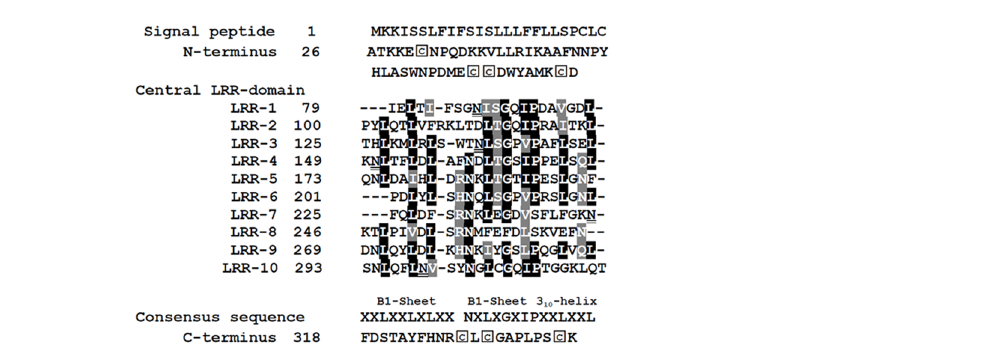
Fig 1. The PGIP-specific consensus sequence xxLxLxx.NxLx..GxIPxxLxxL.xxL in leucine-rich repeat units of CkPGIP1. Secondary structure elements (sheets B1, B2, and 3 10 -helix) are indicated for a homology model of CkPGIP1, which is based on PvPGIP2 (1OGQ) [26]. Putative glycosylation sites are doubly underlined, while conserved C residues are marked using diamonds.